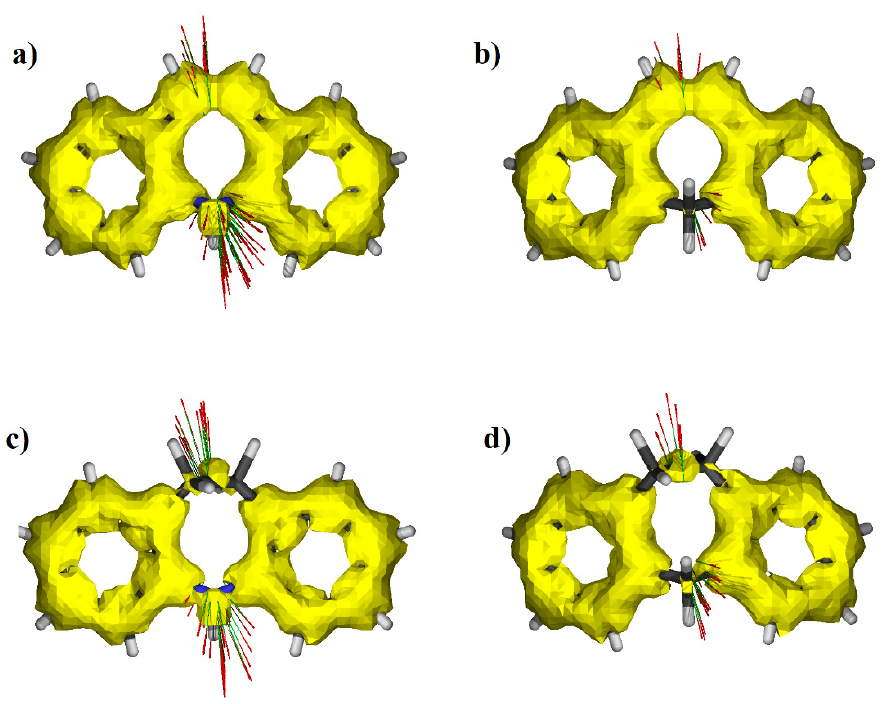
Figure 7. ACID surfaces for the optimized 5 H -dibenzo[b,f]azepine (0.6876) ( a ), 5 H - dibenzo[a,d][7]annulene (0.5448) ( b ), 10,11-dihydro-5 H -dibenzo[b,f]azepine (0.4295) ( c ), 10,11- dihydro-5 H -dibenzo[a,d][7]annulene (0.1863) ( d ). In parentheses are given the HOMED values for the middle ring.